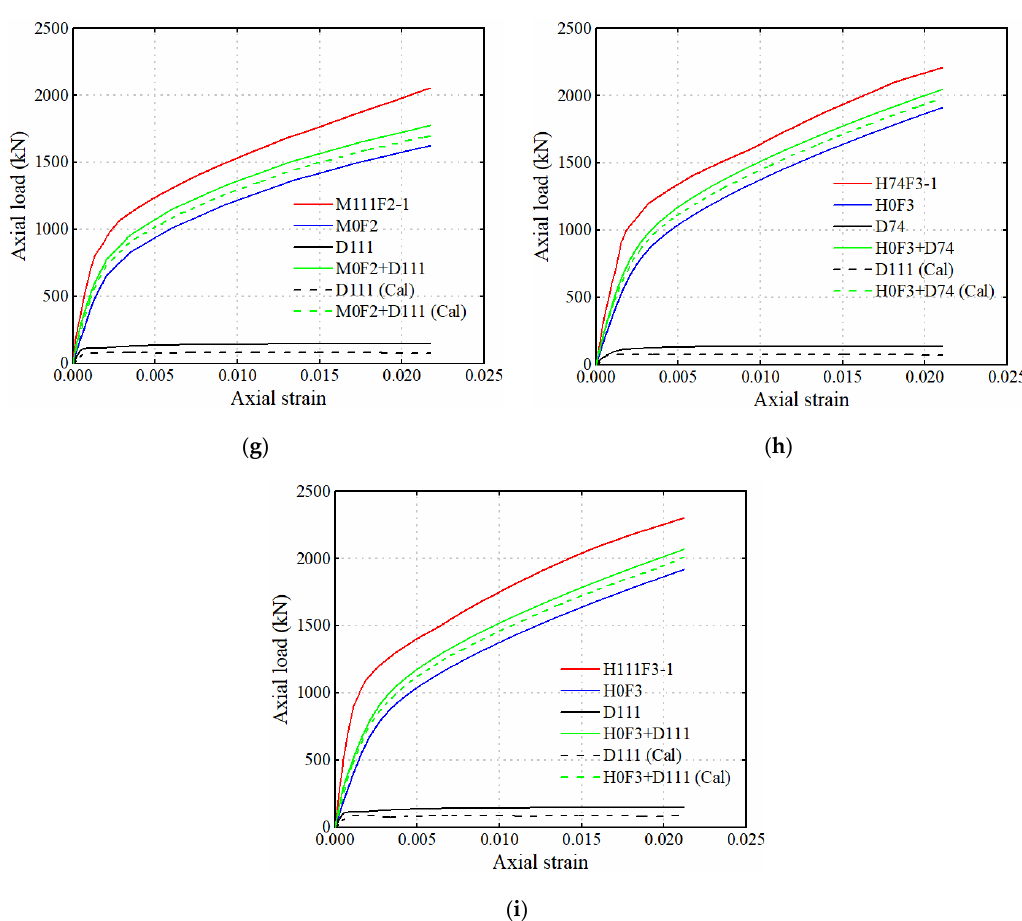
Figure 12. Components of axial load for the specimens with built-in steel tubes: ( a ) L74F1-1; ( b ) L111F1-1; ( c ) M47F1-1; ( d ) M74F1-1; ( e ) M111F1-1; ( f ) M74F2-1; ( g ) M111F2-1; ( h ) H74F3-1; ( i ) H111F3-1.